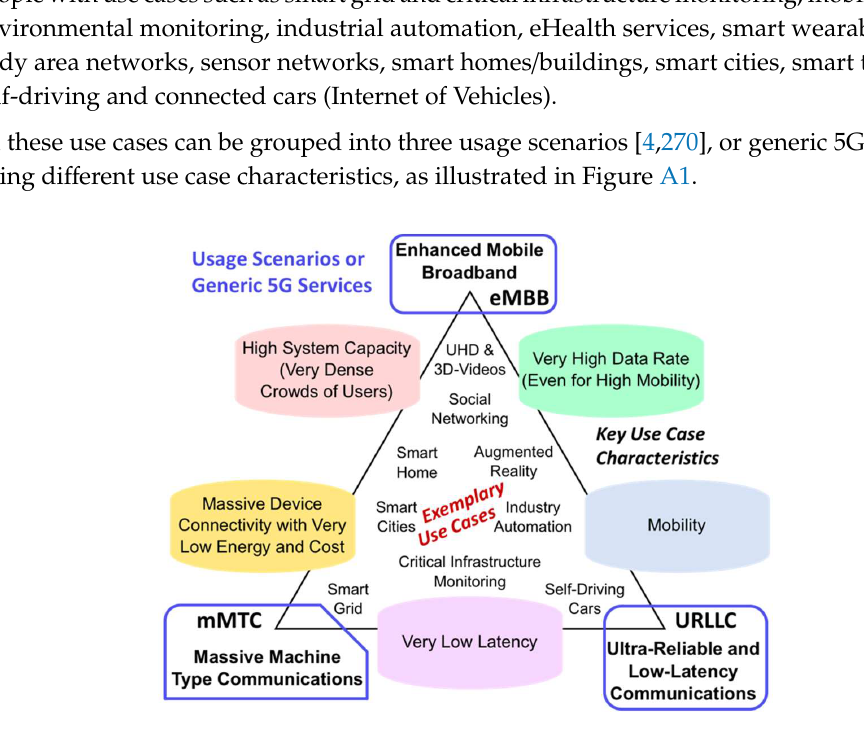
Figure A1. Usage scenarios (generic 5G services) for mobile communications beyond 2020 with key use case characteristics and some exemplary use